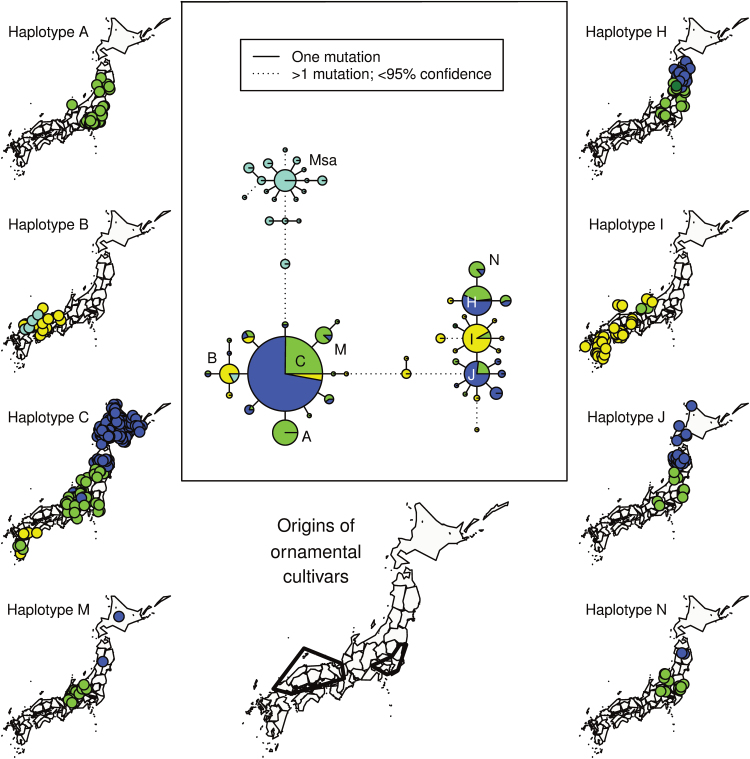
Haplotype network of Miscanthus based upon ten plastid microsatellite markers, and maps of sampling locations of the most common haplotypes. Circle area in the network is proportional to the number of unique accessions with each haplotype, and pie slice area is proportional to the number of individuals in each DAPC group as determined by nuclear SNPs (Fig. 1A, lower bar, with corresponding colours). Msa indicates the sub-network belonging to M. sacchariflorus. The rest of the network is found in M. sinensis. The eight most common haplotypes in M. sinensis are indicated with letters. Haplotypes A, B, C, H, I, and J correspond to identically named haplotypes from Clark et al. (2014). Probable geographic origins of ornamental M. sinensis cultivars (bottom, centre) were determined by the presence of haplotypes A, B, and I and the absence of other haplotypes.